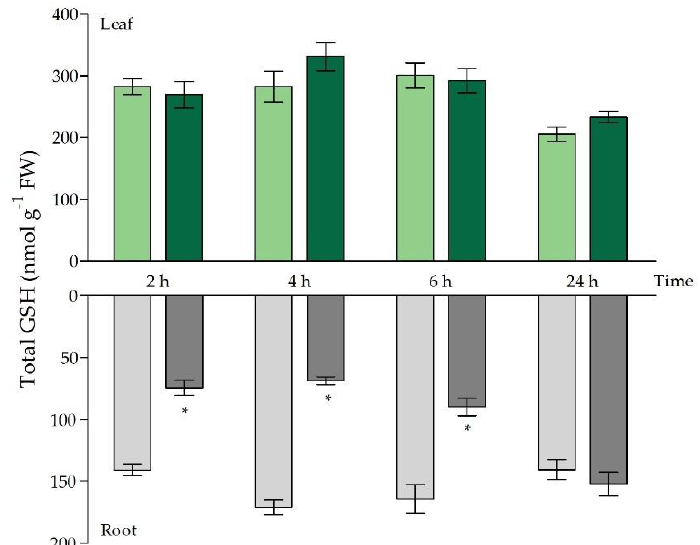
Figure 2. Total glutathione (GSH) concentrations (nmol g − 1 fresh weight) in leaves (green bars) and roots (grey bars) of Arabidopsis thaliana plants grown under control conditions (0 µ M CdSO4, light bars) or exposed to 5 µ M CdSO4 (dark bars) during 2 h, 4 h, 6 h and 24 h after 3 weeks of growth. For each time point, data represent the mean ± S.E. of four biological independent replicates. Significant di ff erences ( t -test: p < 0.05) between control and exposed plants, within each time point, are indicated with an asterisk (*).